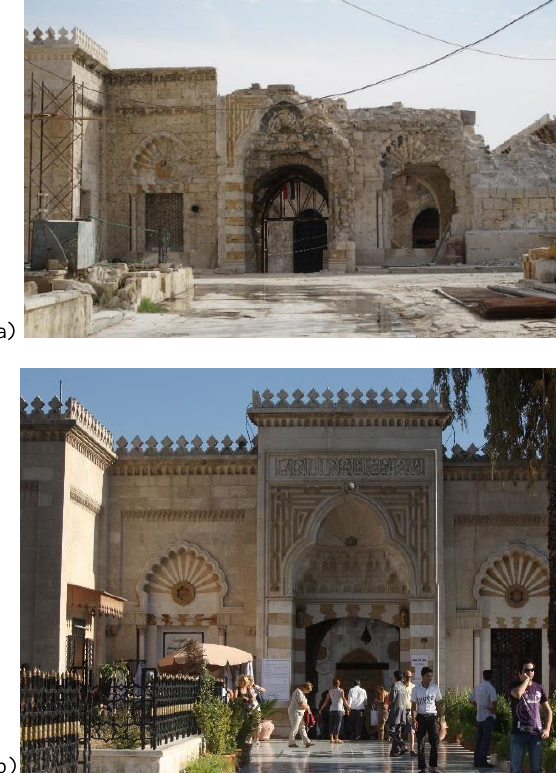
Figure 9: The entrance gate to the great Mosque, current situation (a) and how it was in 2010 (b).